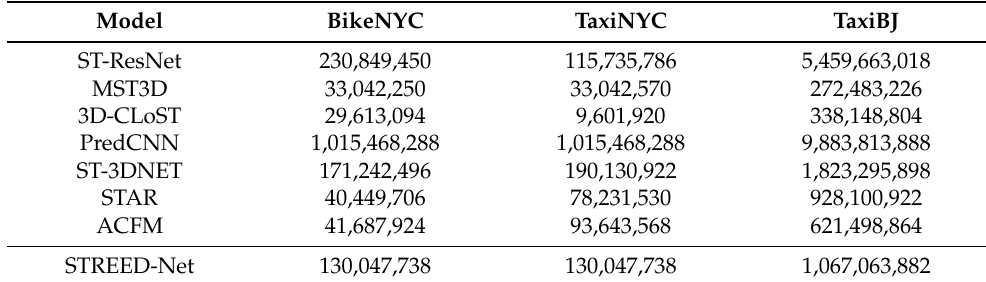
Table 6. Computational complexity (in number of